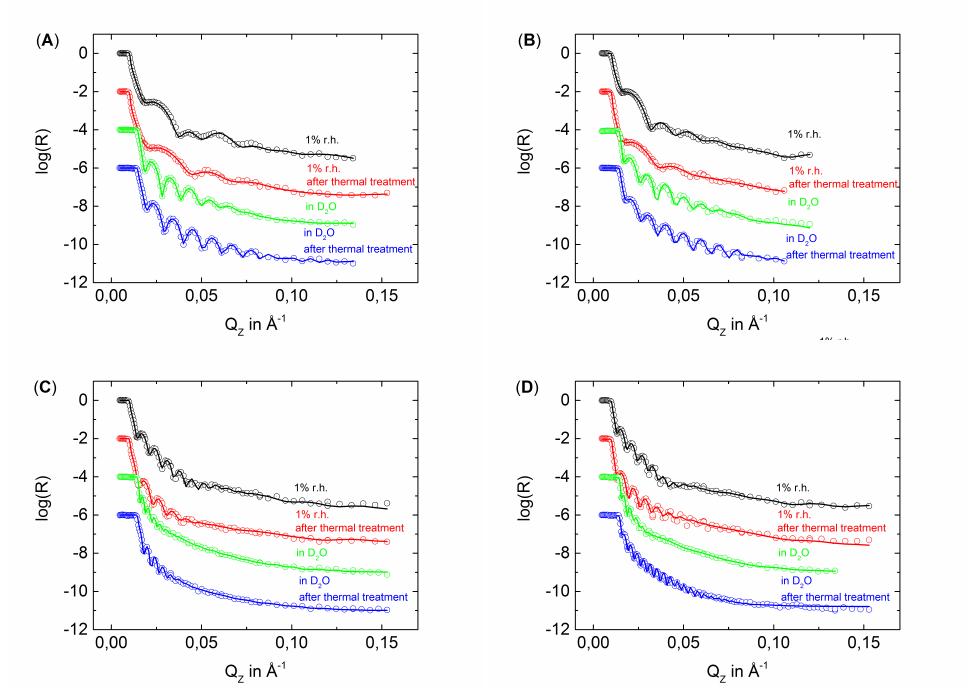
Figure 2. Neutron data of samples D6H4 ( A ); D6H4.5 ( B ); D6H12 ( C ) and D6H12.5 ( D ). The circles represent the measured data while the solid lines correspond to data fits. For the sake of clarity, the data were shifted by a value of − 2(log(0.01)), − 4 and − 6.